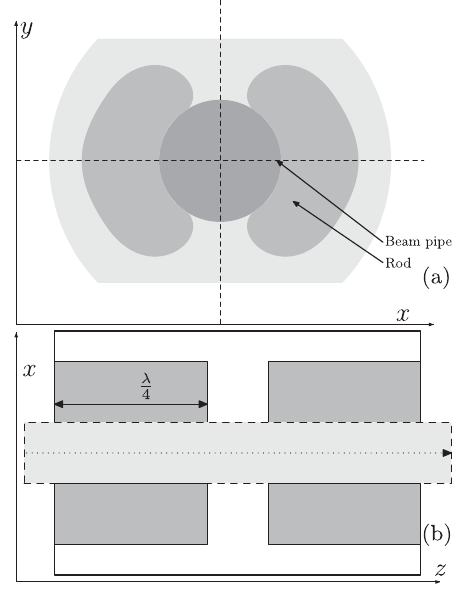
FIG. 2. Four rod cavity design (not to scale) with wavelength λ . The kick of the cavity shown is orientated in the x plane, i.e., a horizontal crab cavity, projected in the (a) x - y and (b) z - x